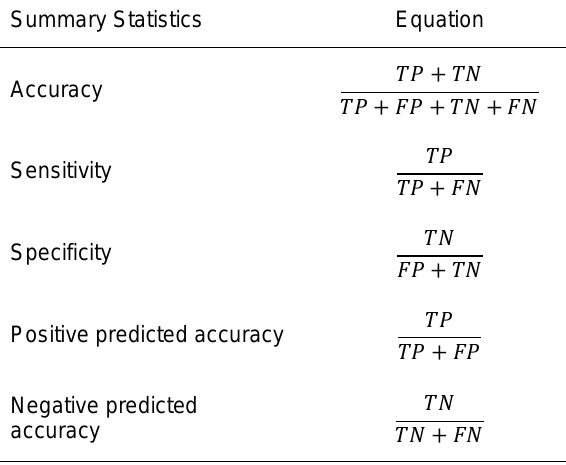
Table 3. Evaluation metrics summary